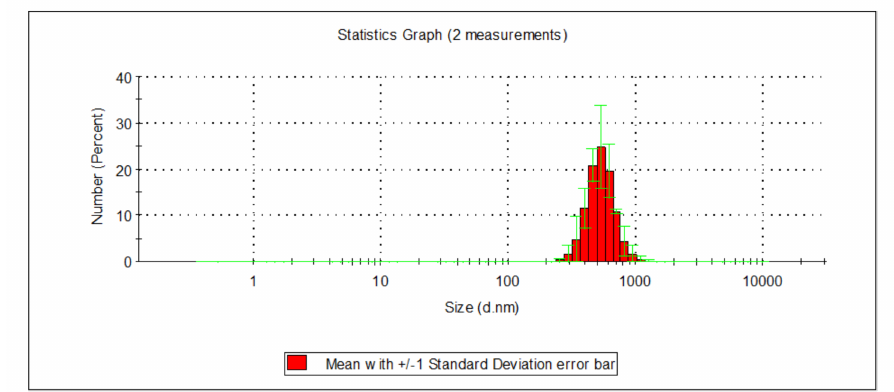
Figure 11. Distribution of particle sizes in water after the disinfection